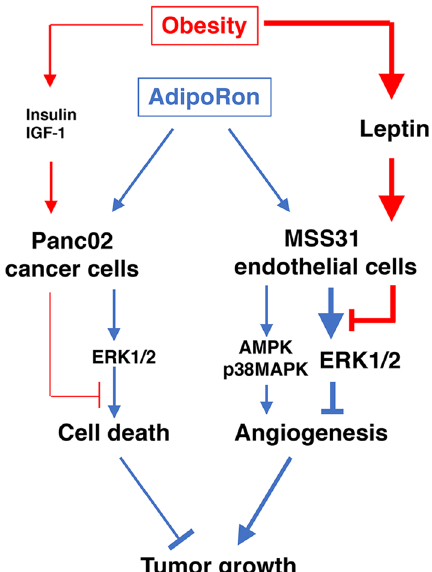
Figure 6. Schematic drawing of the present findings. AdipoRon induces cell death of Panc02 cells partially through ERK1/2 activation. Similarly, AdipoRon suppresses tube formation of MSS31 cells through ERK1/2 activation, which apparently masks the enhancing effect of AMPK and p38 MAPK activation induced by AdipoRon. Obesity-related high insulin and high IGF-1 level slightly recover AdipoRon-induced cell death, while high leptin levels ameliorate the suppression of angiogenesis induced by AdipoRon through inhibition of ERK1/2 activation. Therefore, obesity reduces the anticancer activity of AdipoRon against pancreatic